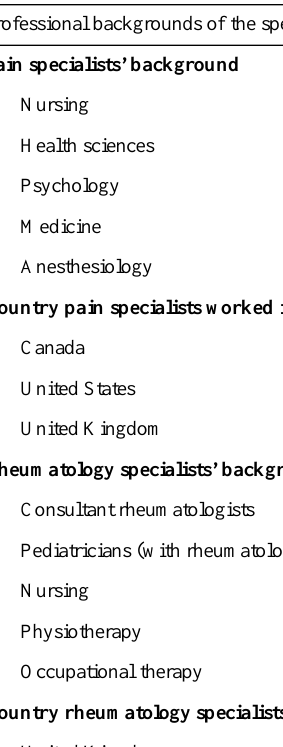
Table 1. Professional background of pain specialists and rheumatology specialists.